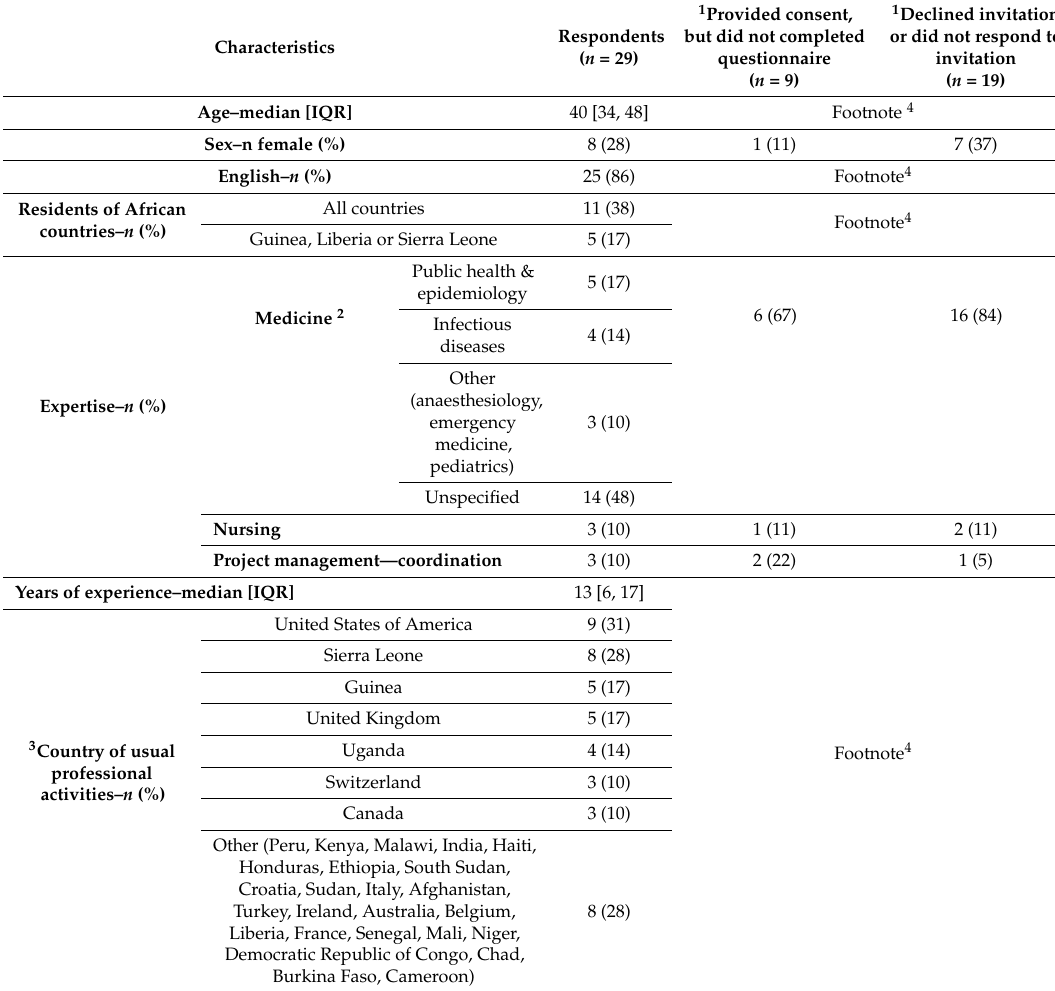
Table 1. Respondents’ demographic